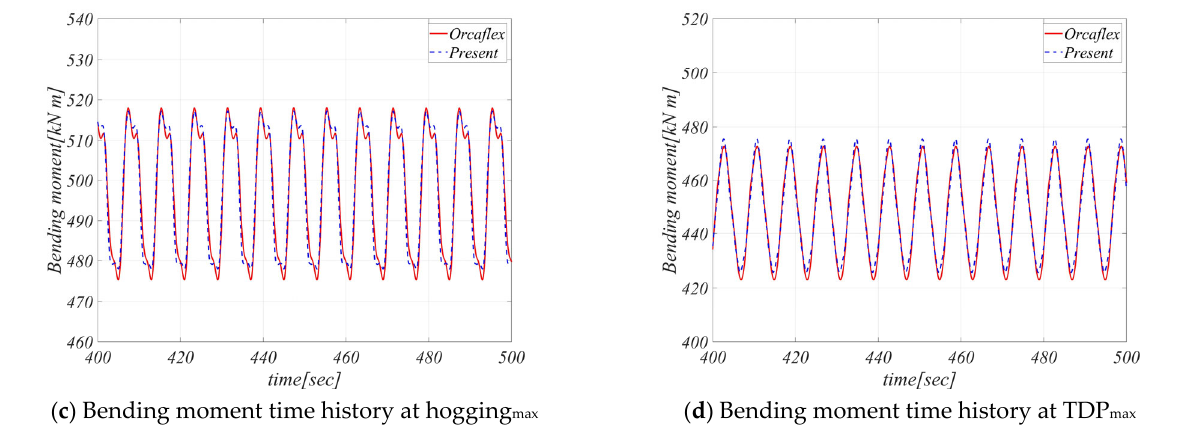
Figure 12. Dynamic tension and bending moment from heave ‐ excited motion with shear current.